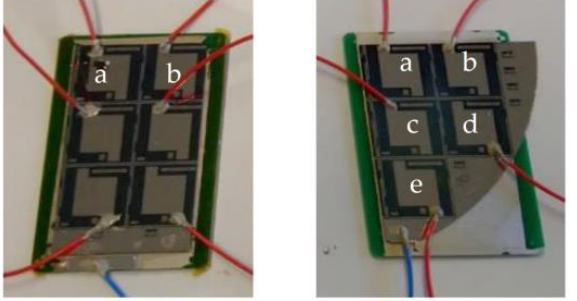
Figure 4. Wiring of the mirror prototypes for the optical testing. Sample 1 ( left ) and 2 ( right ). Letters indicate individual mirrors identifiers of the devices that were optically characterized.